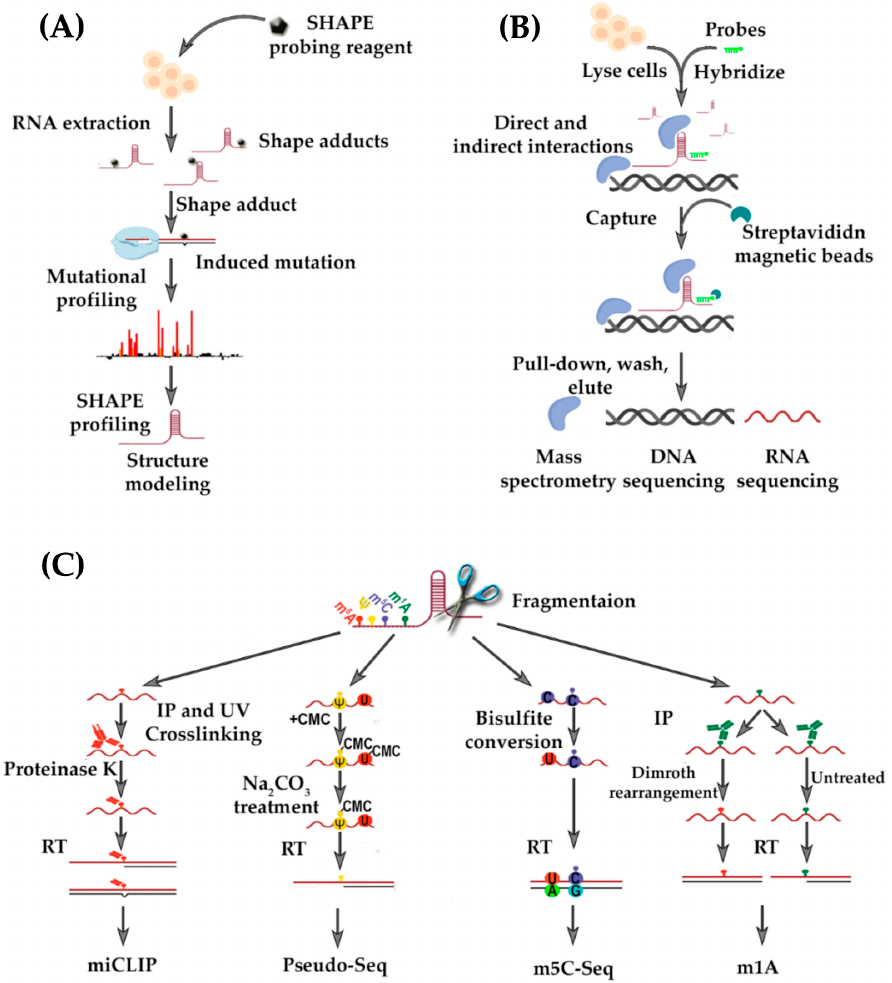
Figure 5. Novel molecular approaches to address the structure-to-function relationship of gammaherepsvirus-encoded lncRNAs. ( A ) RNA secondary structure analysis by selective 2 (cid:48) -hydroxyl acylation analyzed by primer extension (SHAPE) takes advantage of electrophilic chemical probes that target single-stranded or structurally unconstrained nucleotides and modify them at the 2 (cid:48) -hydroxyl group. When coupled with mutational profiling (MaP), the modified nucleotides are detected as internal miscoding nucleotides during reverse transcription followed by massively parallel sequencing; ( B ) RNA antisense purification (RAP) is used to purify a target lncRNA in complex with other RNAs, proteins and DNA. Biotinylated probes (light green) designed to associate with the target lncRNA (brown) are hybridized to the transcript that has been specifically cross-linked to interacting partners. Streptavidin magnetic beads (dark green) capture the biotinylated probes (light green) to pull-down the lncRNA and associated molecules, i.e., other RNAs, proteins, and DNA (blue) for further analysis by mass spectrometry, DNA-seq or RNA-seq; ( C ) Examples of deep-sequencing based mapping techniques that are used to address the four most common epitranscriptomic modifications in RNA. The N 6 -methyladenosine (m 6 A, red) is detected with individual-nucleotide-resolution cross-linking and immunoprecipitation (miCLIP) methodology. Here, immunoprecipitation (IP) and UV crosslinking with m 6 A-specific antibodies is coupled with reverse transcription and deep-sequencing, and the sites of modification are detected as either misincorporation of base-pairs or truncation. Pseudouridine ( Ψ , yellow) is detected by CMC-derivatization, where sodium carbonate removes the CMC derivative from non-pseudouridine modifications. The 5-methylcytosine (m 5 C, purple) uses bisulfite conversion that causes non-methylated cytosines to be converted to guanine. The N 1 -methyladenosine (m 1 A, green), similar to miCLIP, relies on using m 1 A-specific